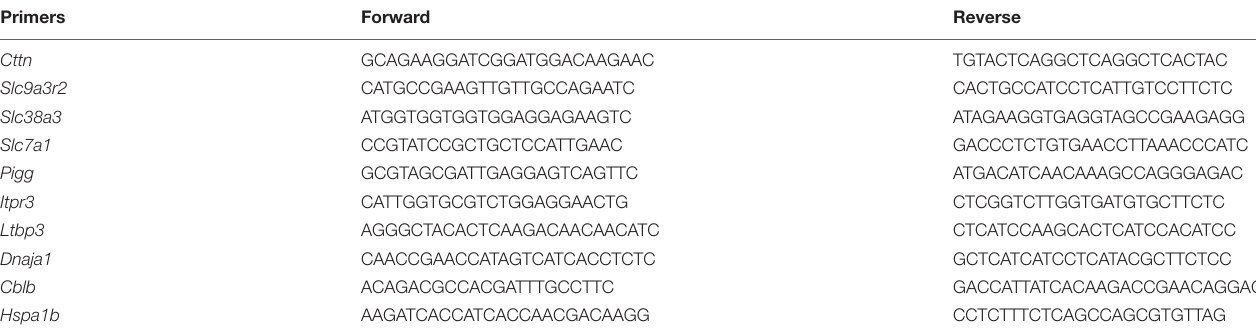
TABLE 1 | The primers used in qPCR.